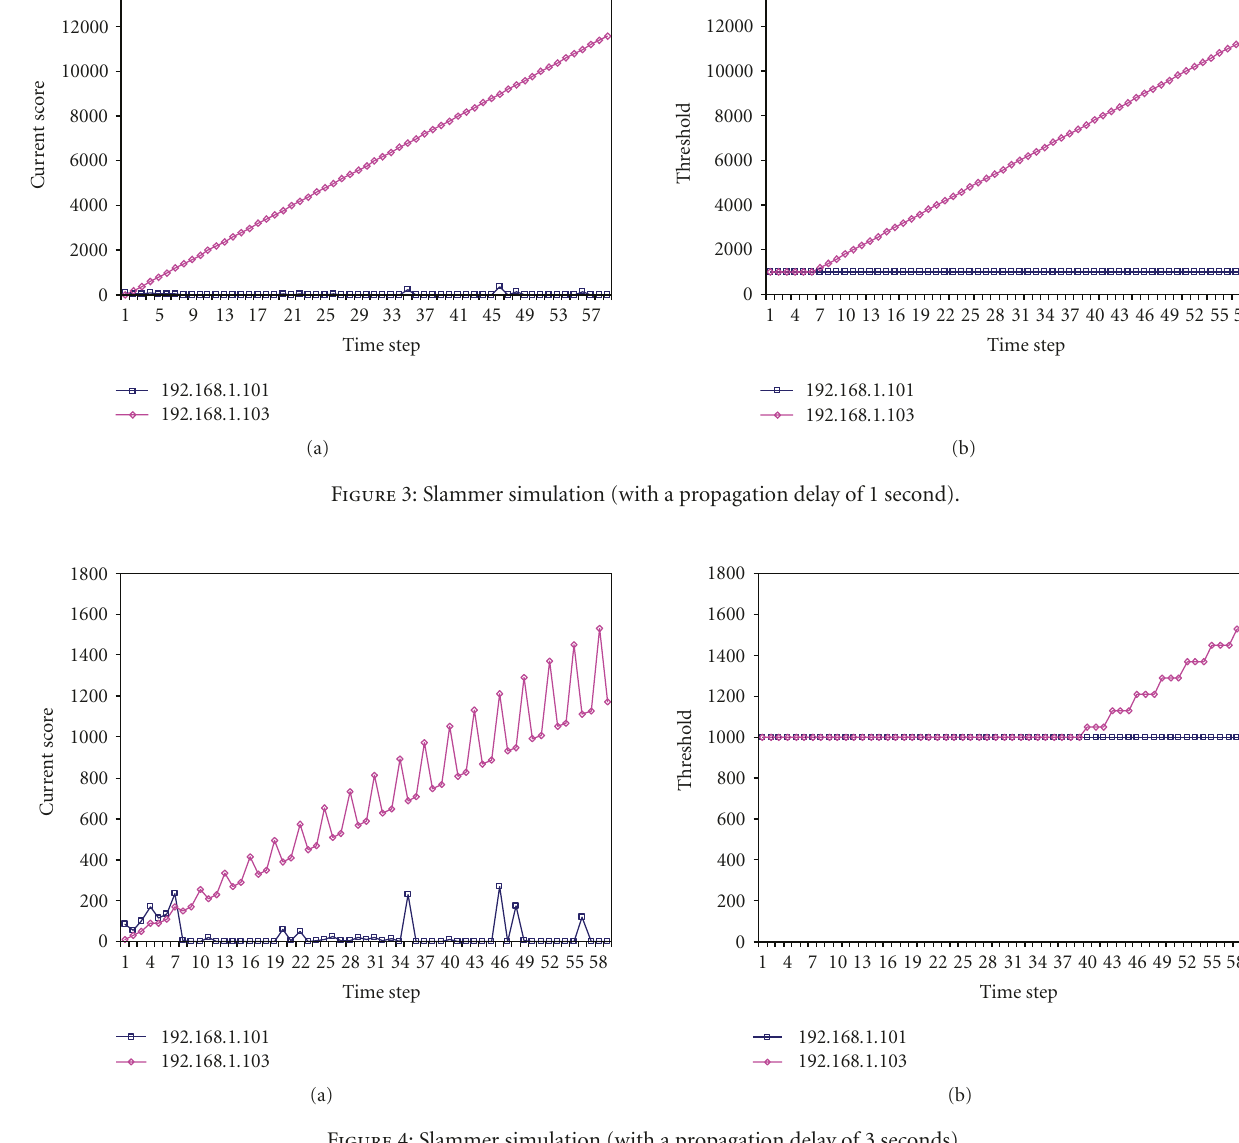
Figure 4: Slammer simulation (with a propagation delay of 3